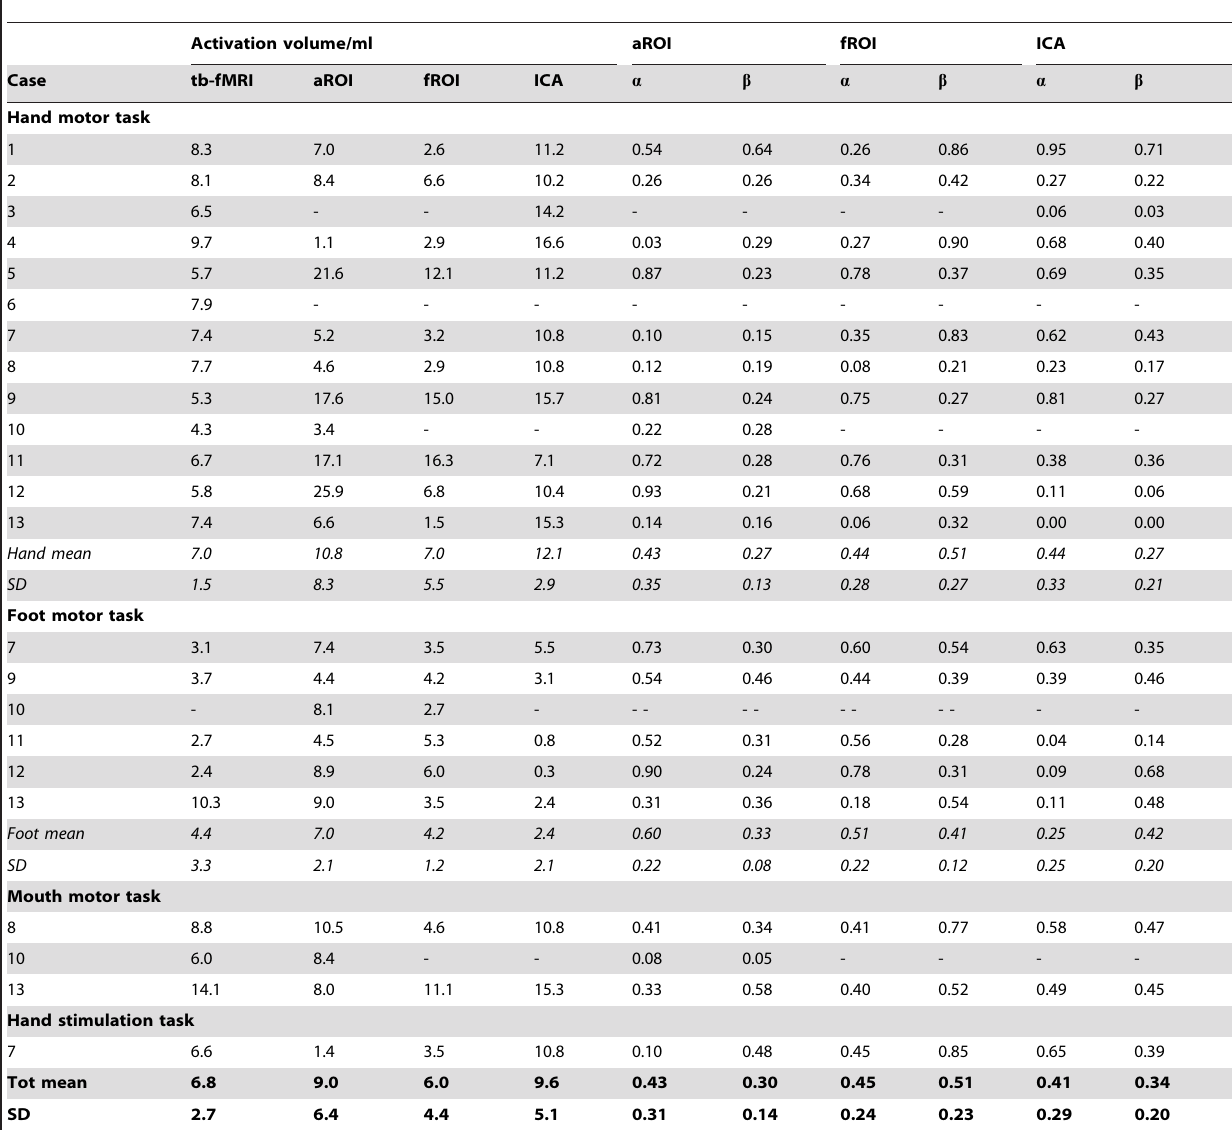
Table 4. Activation volumes (calculated over the corresponding anatomical masks), overlap sensitivity ( a ) and specificity ( b ) of resting-state fMRI (rs-fMRI) with respect to task-based fMRI (tb-fMRI), obtained with operator-dependent